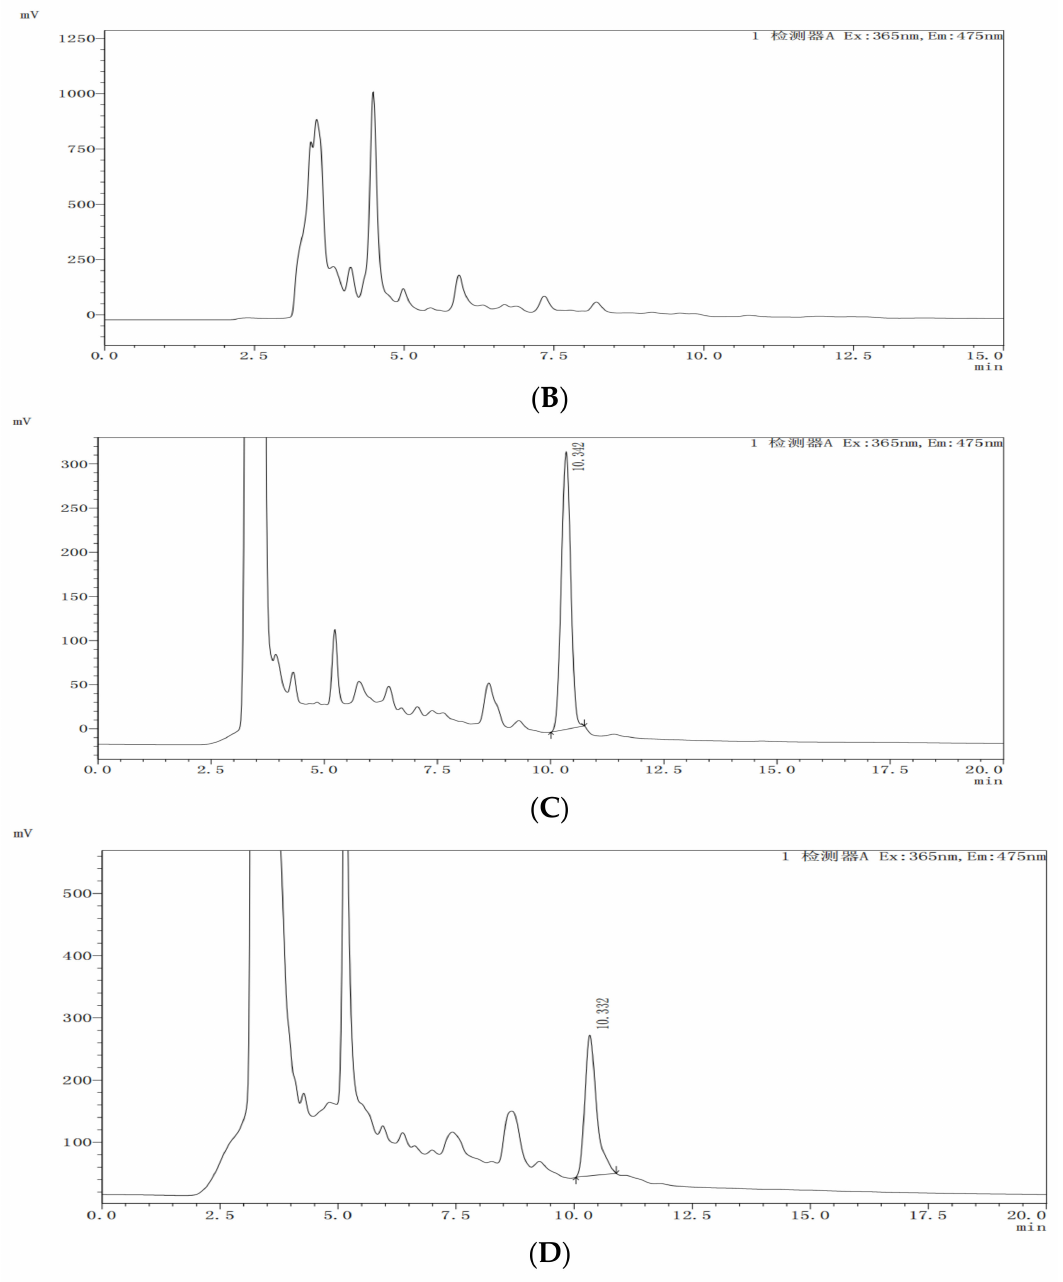
Figure 2. Chromatogram of emamectin benzoate standard, blank, spiked sample, and real sample (Lateral axis is time, and longitudinal axis is response intensity). ( A ) emamectin benzoate standard (1 mg/kg); ( B ) longan CK; ( C ) spiked longan sample (0.1 mg/kg); ( D ) longan real sample. Note: The Chinese letters in this figure mean